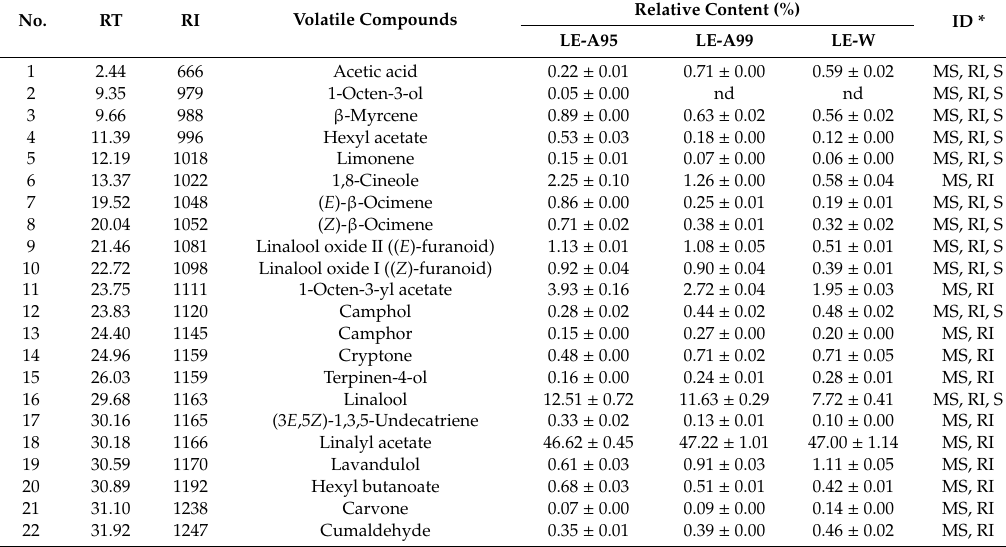
Table 1. Volatile compositions of lavender extracts with di ff erent extraction